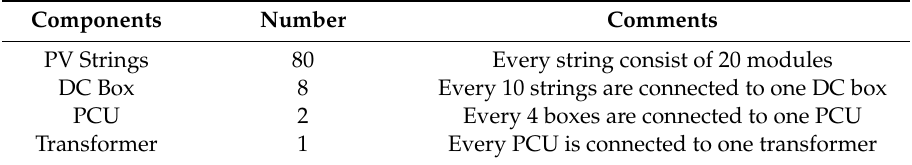
Table 5. Summary of the system components for the developed model of the PV power plant.